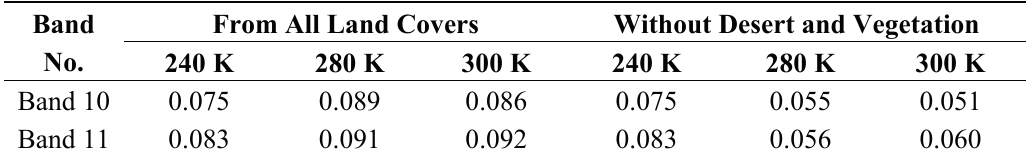
Table 2. NE Δ T of the TIRS two bands at different brightness